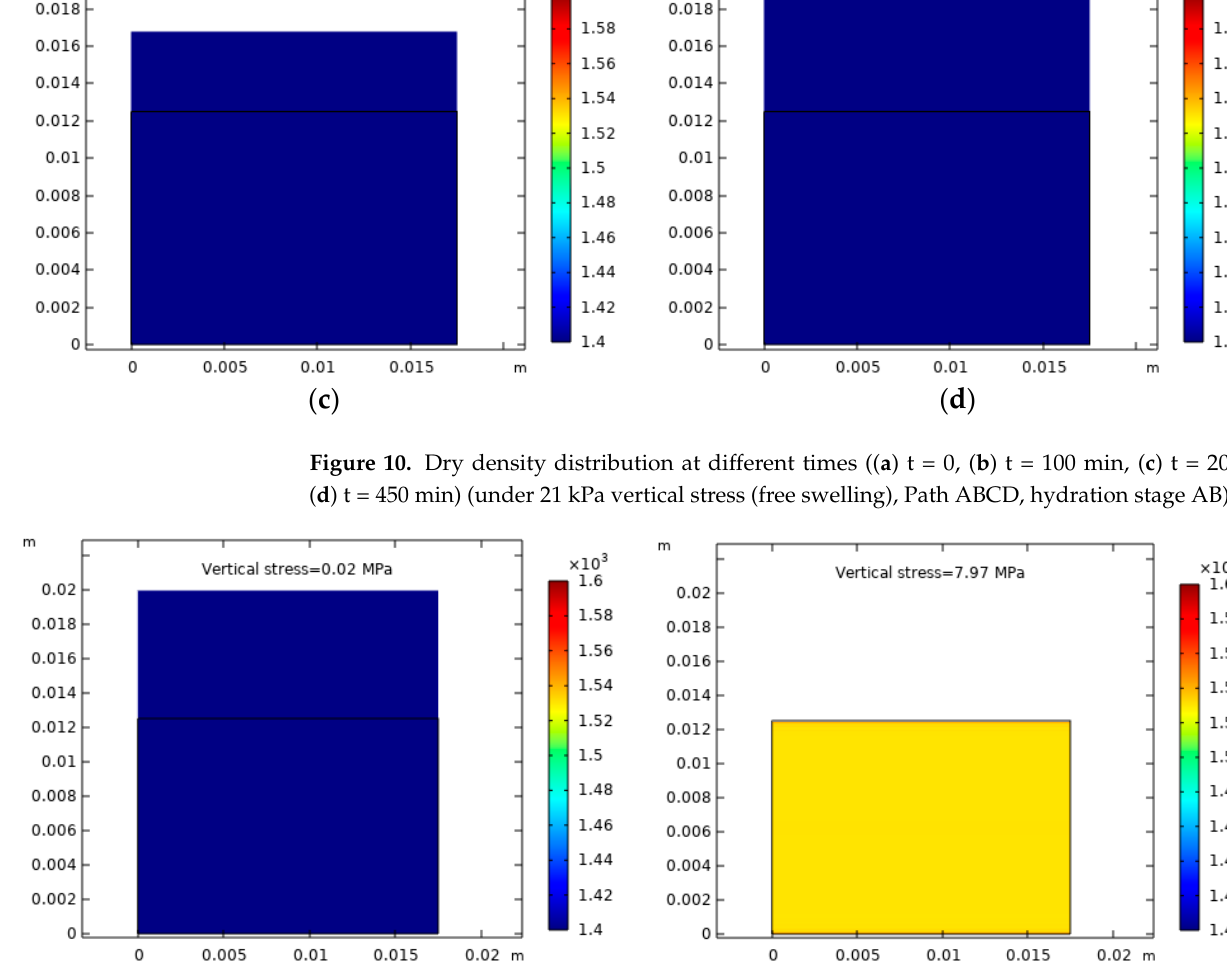
Figure 10. Dry density distribution at different times (( a ) t = 0, ( b ) t = 100 min, ( c ) t = 200 min, ( d ) t =